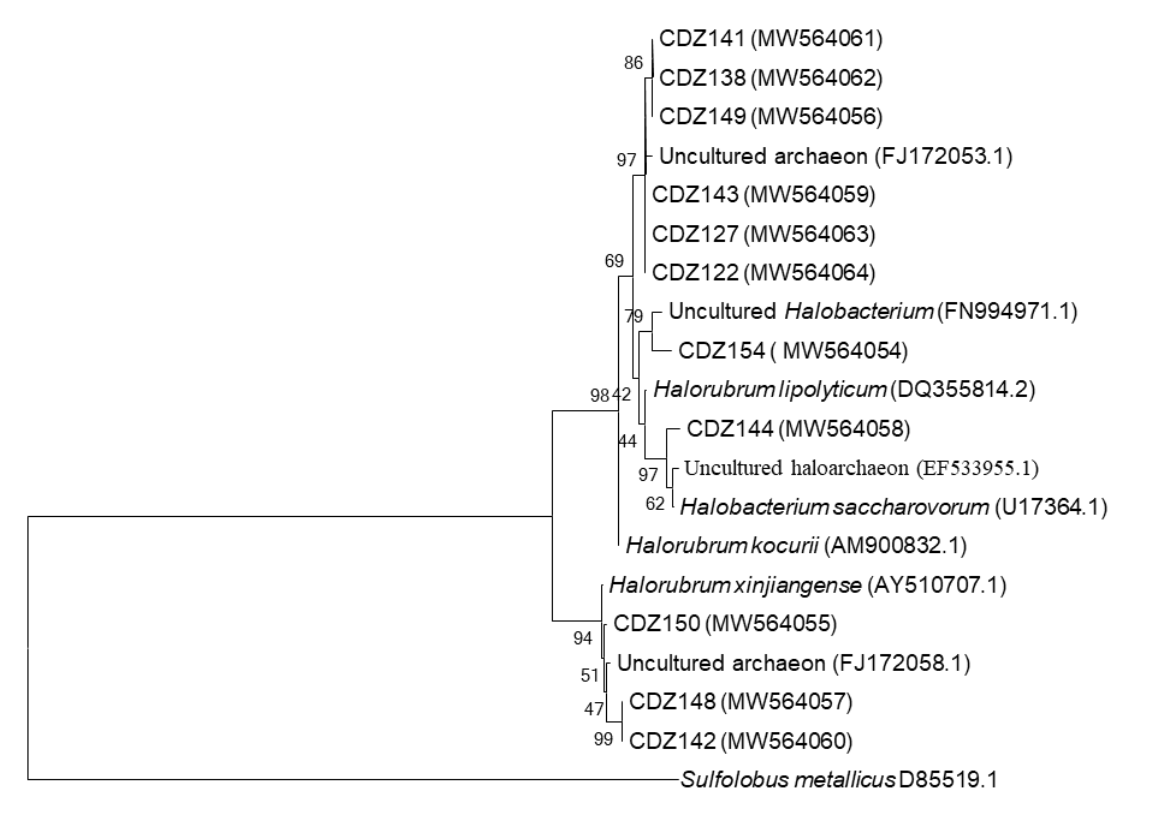
Figure 6. Neighbor-joining tree showing relationships among CDZ clones’ and their closest relatives retrieved from RDPII database. Evolutionary distances were calculated using the method of maximum composite likelihood and the topology was inferred using the neighbor-joining method using MEGA 6 software. Numbers on the nodes present % bootstrap values based on 1000 replicates. Scale bar represents 0.05 substitutions per site. The 16S rRNA gene sequence of Sulfolobus metallicus was arbitrarily chosen as the outgroup to define the root of the tree. Accession number of sequences are shown in parenthesis.